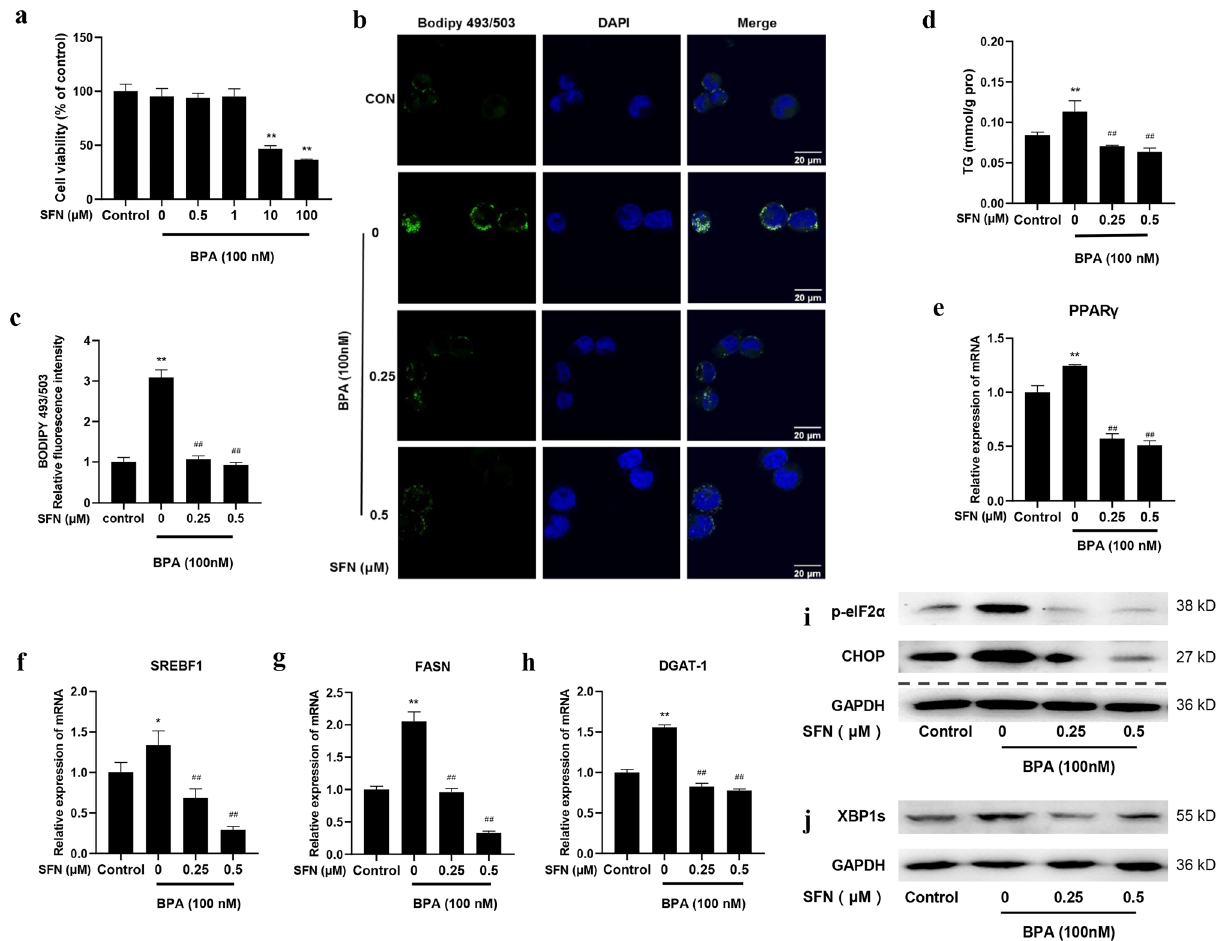
Figure 3. SFN ameliorated BPA-induced lipid accumulation and ER stress in LO2 cells. ( a ) LO2 cells were treated with 100 nM BPA and designated concentrations of SFN (0, 0.5, 1, 10, and 100 μM) for 24 h. Cell viability was evaluated by MTT assay. ( b ) BODIPY 493/503 staining for lipid droplets. Scale bar = 20 μm. ( c ) Quantification of the relative BODIPY 493/503 fluorescence intensity. ( d ) The TG levels in LO2 cells. The mRNA expression levels of ( e ) PPARγ, ( f ) SREBF1, ( g ) FASN, and ( h ) DGAT-1 were detected by qRT-PCR. The levels of ( i ) p-eIF2α, CHOP, and ( j ) XBP1s were measured by Western blotting. The blots of p-eIF2α and GAPDH were cropped from different portions of the same membrane. CHOP blot was not cropped from the same membrane as the above two blots but from the same sample. The blots of XBP1s and GAPDH were cropped from different parts of the same membrane. The original blots are presented in Supplementary Figs. S5, 6. Data are expressed as the mean ± SD of 3 independent experiments. * p < 0.05 and ** p < 0.01, when compared with the control group; # p < 0.05 and ## p < 0.01, when compared with the BPA